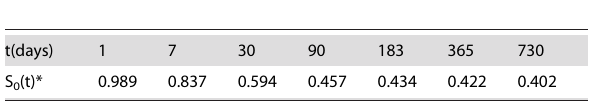
Table 6. Underlying survival function for the new ACLF prognostic